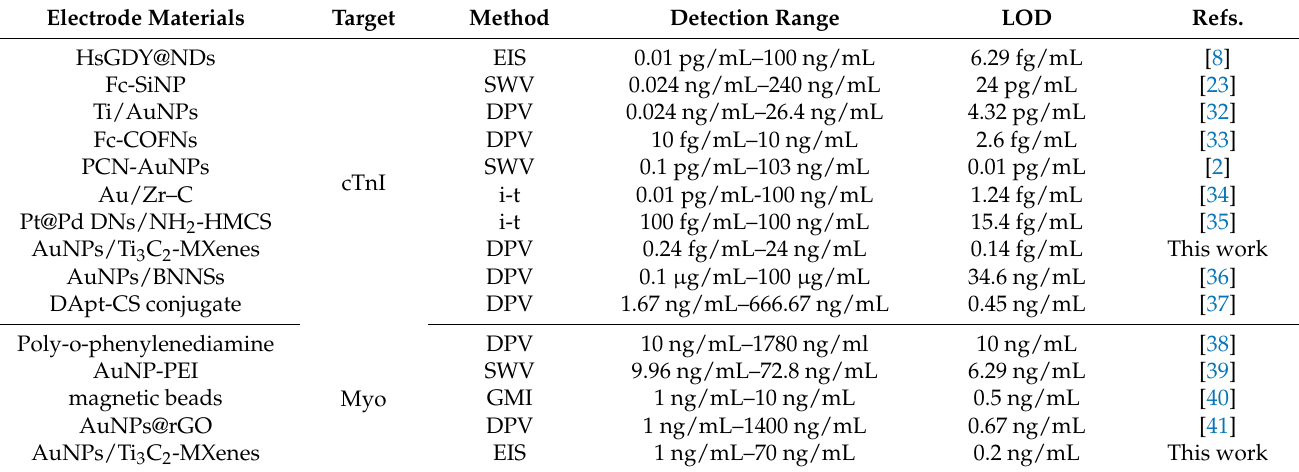
Figure 3. ( A ) The DPV responses of Apt cTnI sensor for detecting cTnI. ( B ) The linear relationship between DPV current and the logarithm of cTnI concentration. ( C ) The EIS responses of Apt Myo sensor for detecting Myo. ( D ) The linear relationship between Ret and the logarithm of Myo concentration. Table 1. Performance comparison of the developed sensor with those in the literature for cTnI and Myo